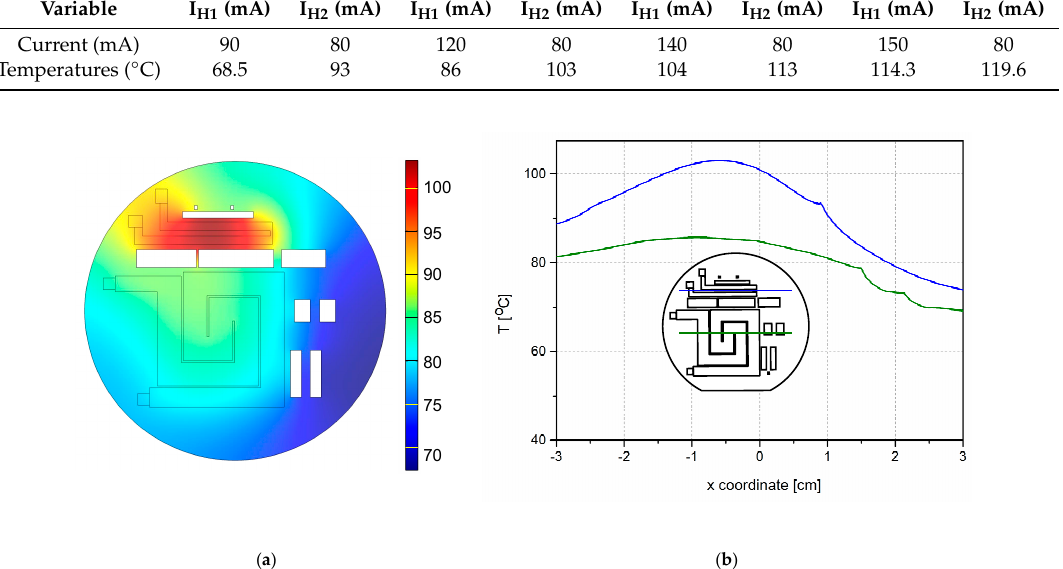
( b ) Figure 4. Simulation of temperature distribution in and around the monolithically integrated p-type heaters in the microreactor without thermal isolation between the heaters for the current values I H2 = 80 mA and I H1 = 120 mA after 20 min; ( a ) spatial distribution of temperature; ( b ) temperature gradient across the centers of both heaters. The inset shows both heaters on the wafer, as well as the thermal isolation apertures (centers are marked by horizontal lines). Green lines denote the larger heater H1, while blue lines correspond to the smaller heater H2. 3.2. Experimental Results We performed temperature measurements for the same sets of applied currents we used in our simulations. To supply a constant current to obtain the required temperature, we connected the contact pads of the heaters to the dual output DC power supply Agilent E3466A. Temperature, together with the solution concentration and the retention time, obviously represents one of the key parameters for nanoparticle synthesis in every high-temperature microreactor. The shapes and the